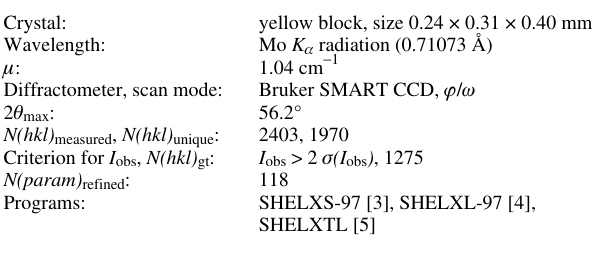
Table 1. Data collection and handling.